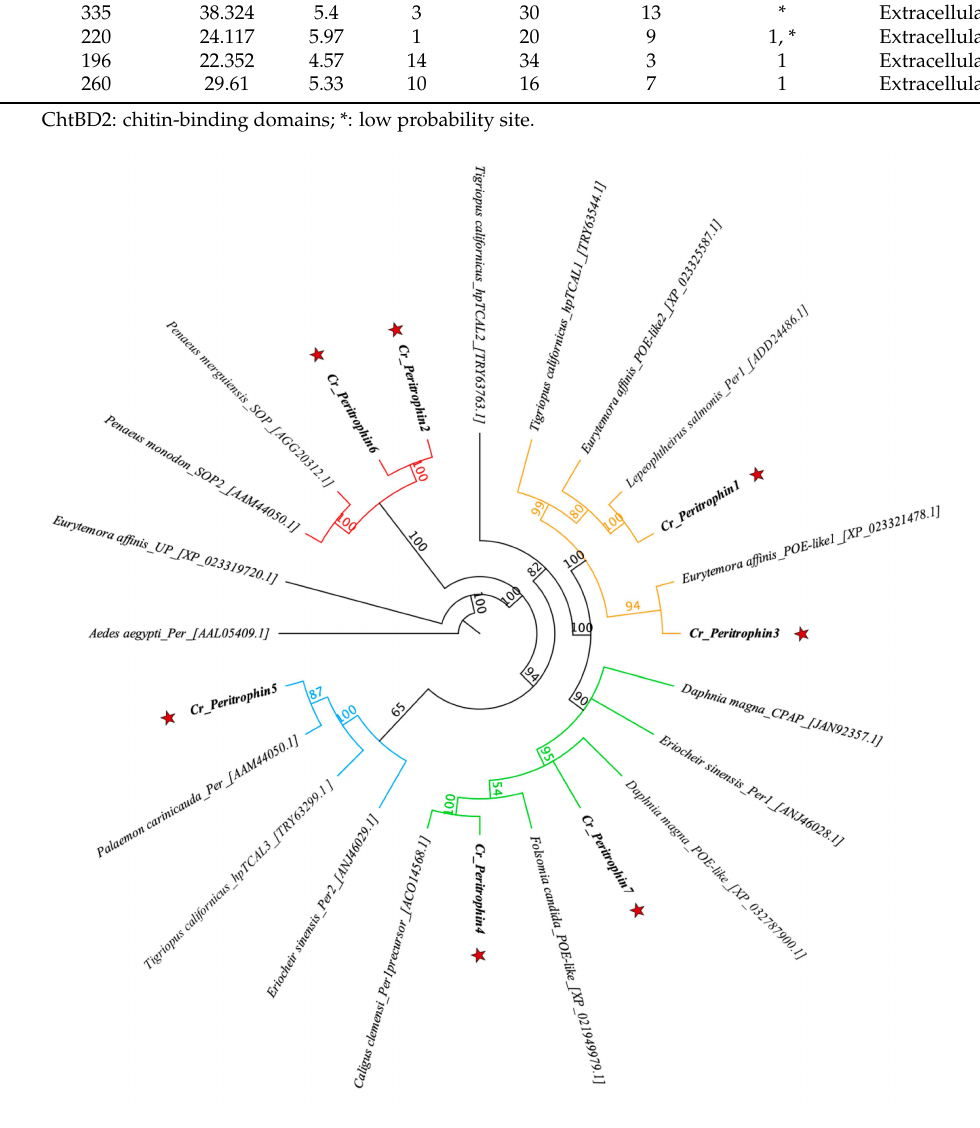
Figure 1. Phylogenetic analysis of sea louse peritrophin proteins. Jukes–Cantor genetic distance model was used to determine the bootstrapping indicated in the nodes. Sequence access numbers are found next to species names. The Cr_Per sequences are marked with a red star. The different clades are shown in red, orange, green, and